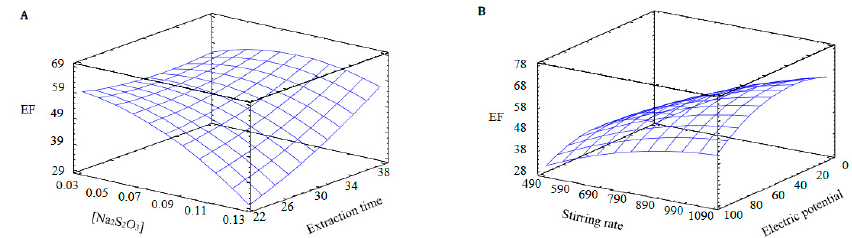
Figure 2. Response surface for Draper–Lin design: ( A ): electric potential, 50 V; stirring rate, 750 rpm. ( B ): extraction time, 30 min; [Na 2 S 2 O 3 ] 0.075 N.